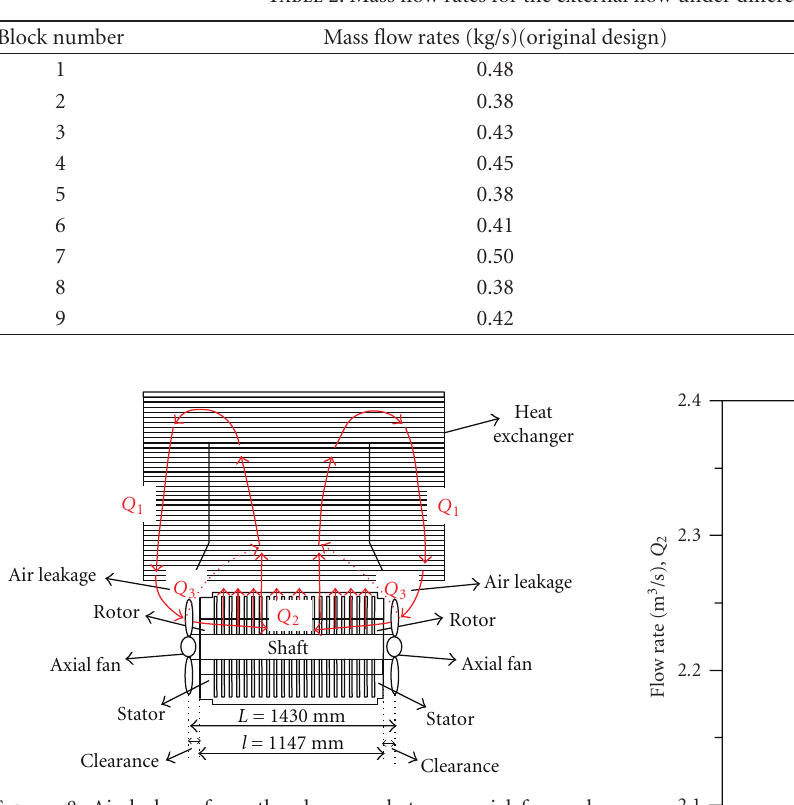
Figure 8: Air leakage from the clearance between axial fan and stator.